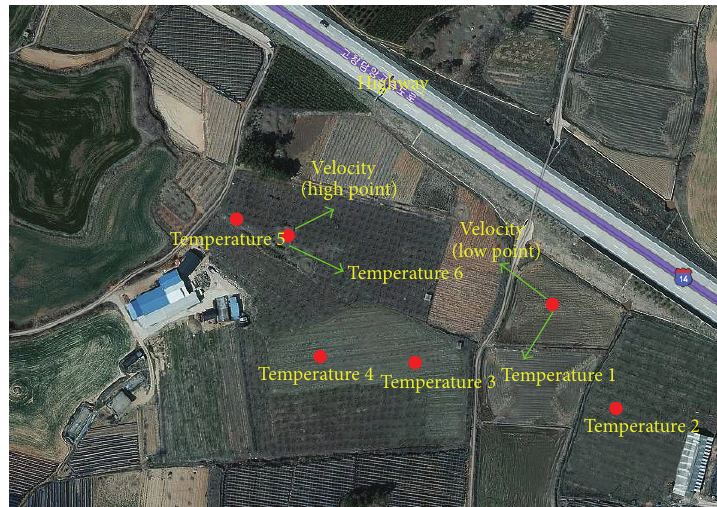
Figure 10: Field-measured